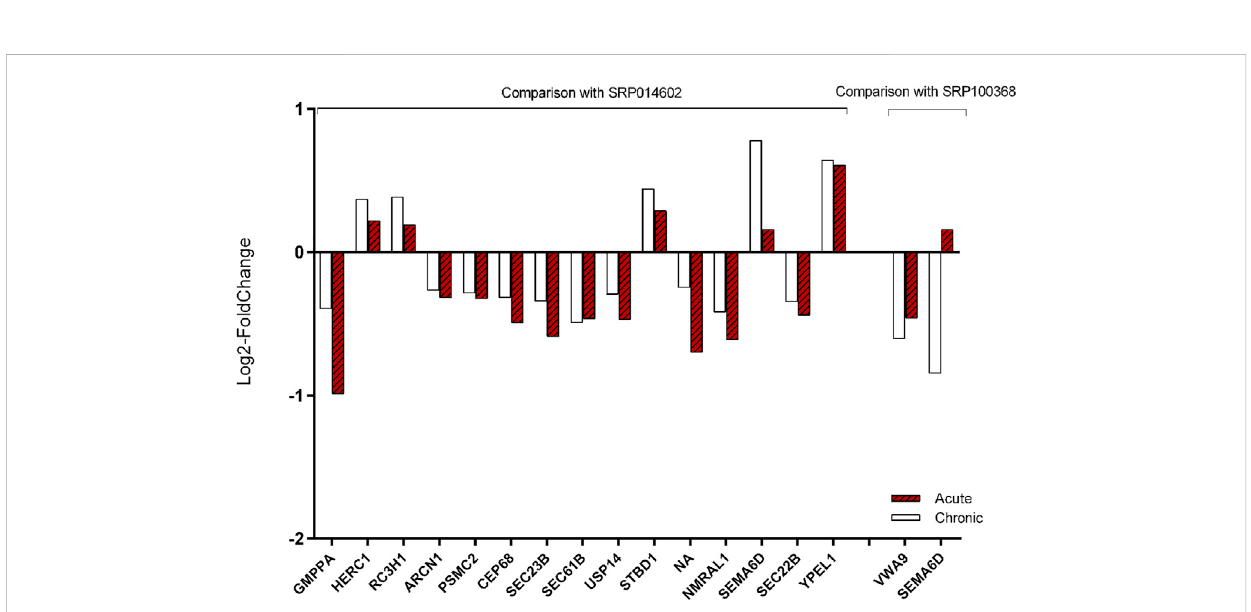
FIGURE 9 Validation of the expression modi fi cation of 17 meta-genes by two additional RNA-seq datasets. The expression fold changes of the 17 meta-genes were strongly in agreement with those in the two validation experiments. Since we could not fi nd other datasets from the acute heat stress experiments, we used two datasets that belonged to chronic heat